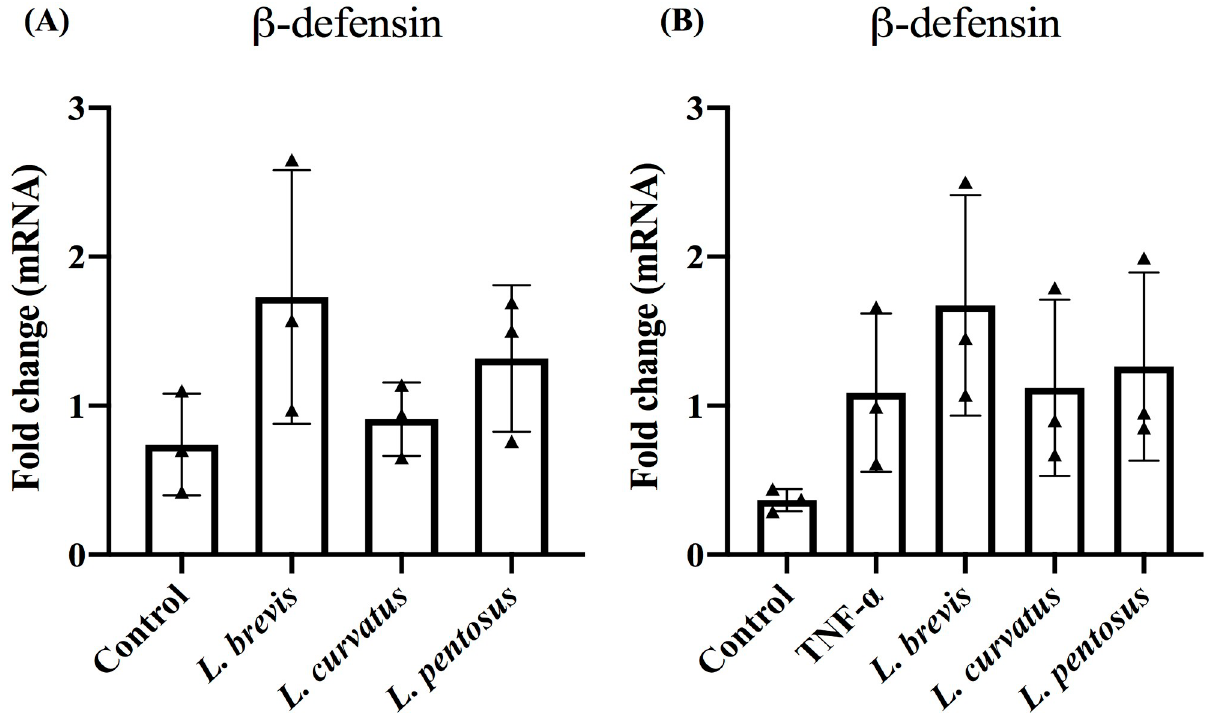
Fig 2. Lactobacillus strains modulate TNF- α induced β -defensin-2 expression in IECs. Caco2 cells were pre-stimulated separately with Lactobacillus alone (A) and post-stimulation with TNF- α 12 h (B). The expression of β -defensin-2 expression was analyzed by RT-PCR. Caco2 cells with or without presence of TNF- α were used as controls. The results represented here is an average values (mean ± S.D) of three independent values. Significant differences between the groups, � p < 0.05.